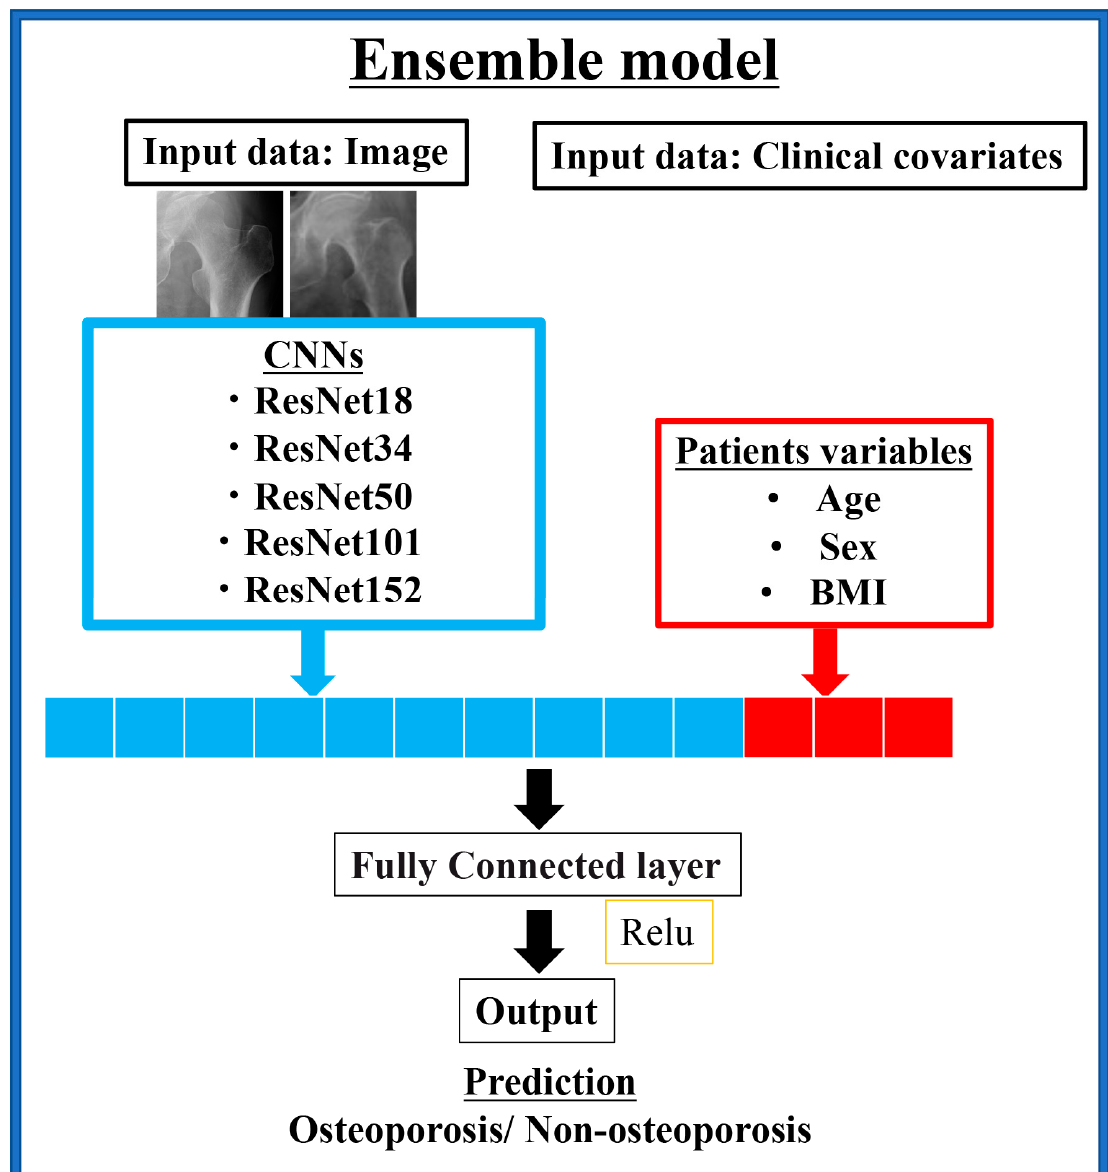
Figure 2. Deep neural network architecture that combines image data and clinical patient variables.